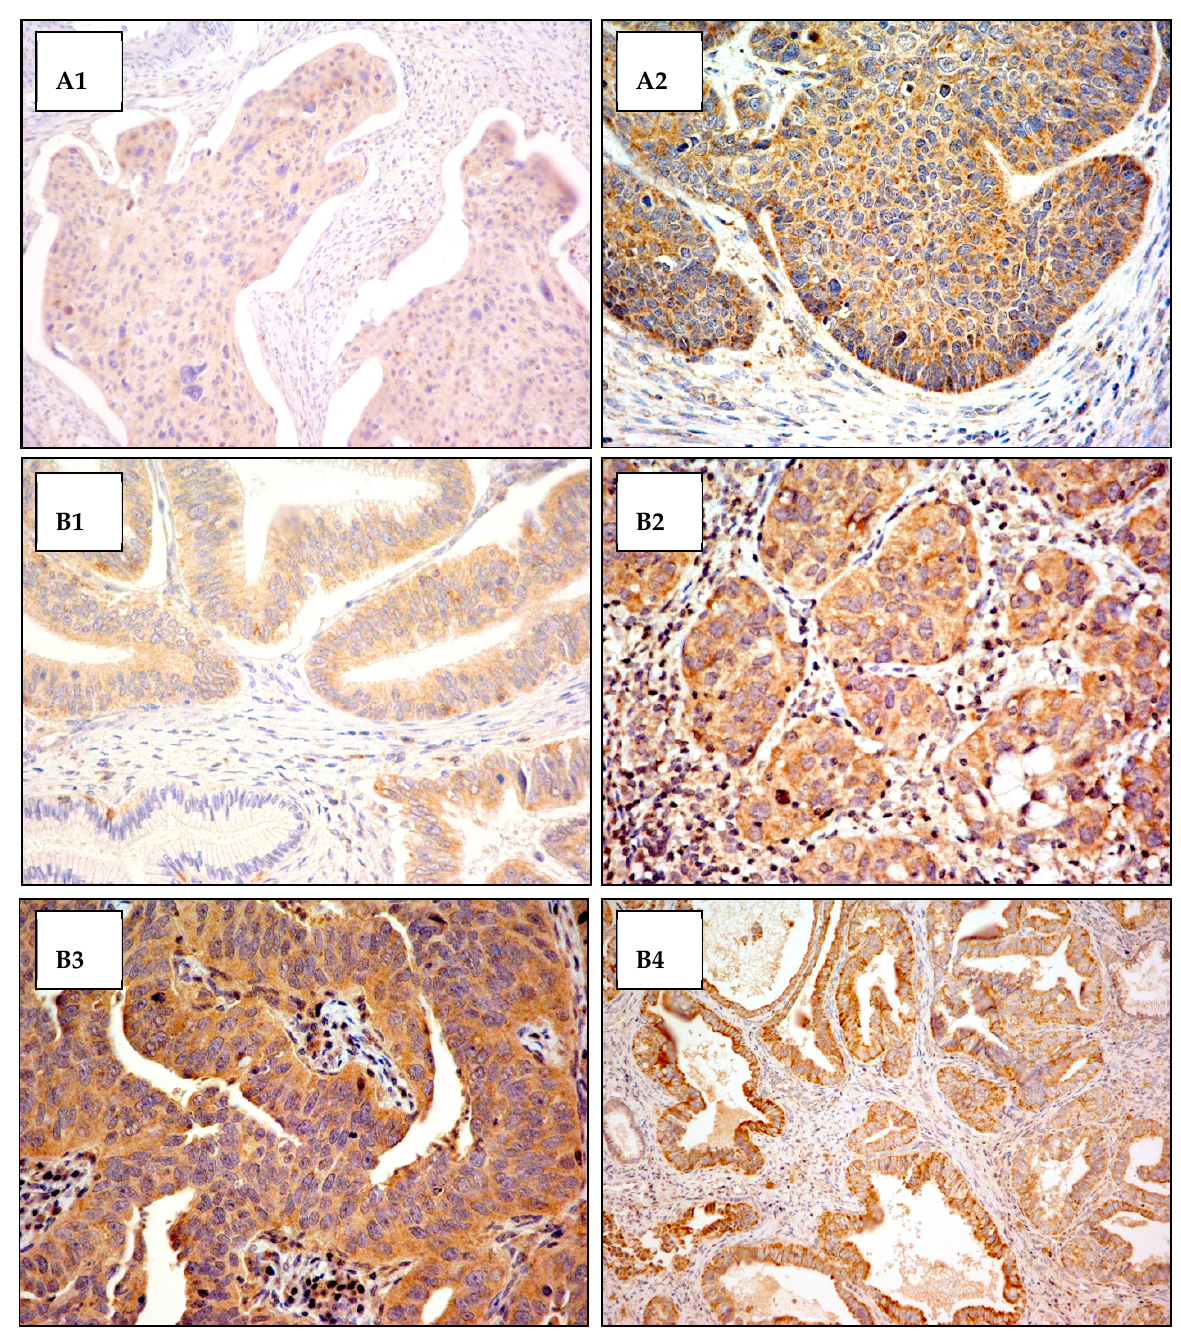
Figure A2. Cytoplasmic VEGF-C antibody staining. Exemples of cytoplasmic VEGF-C antibody staining in squamous cell carcinoma and adenocarcinoma of the cervix. The cytoplasmic staining intensity was scored from 0 (not staining) to 3 (most intensely stained). ( A ) Squamous cells carcinoma: ( A1 ) staining score 1+ (original magnification 200 × ); ( A2 ) staining score 2+ (original magnification 400 × ). ( B ) Adenocarcinoma: ( B1 ) staining score 1+ in tumor area and staining score 0 in normal gland (original magnification 400×); ( B2 ) staining score 2+ (original magnification 400×); ( B3 ) staining score 3+ (original magnification 400×); ( B4 ) staining score 3+ (original magnification 200×).